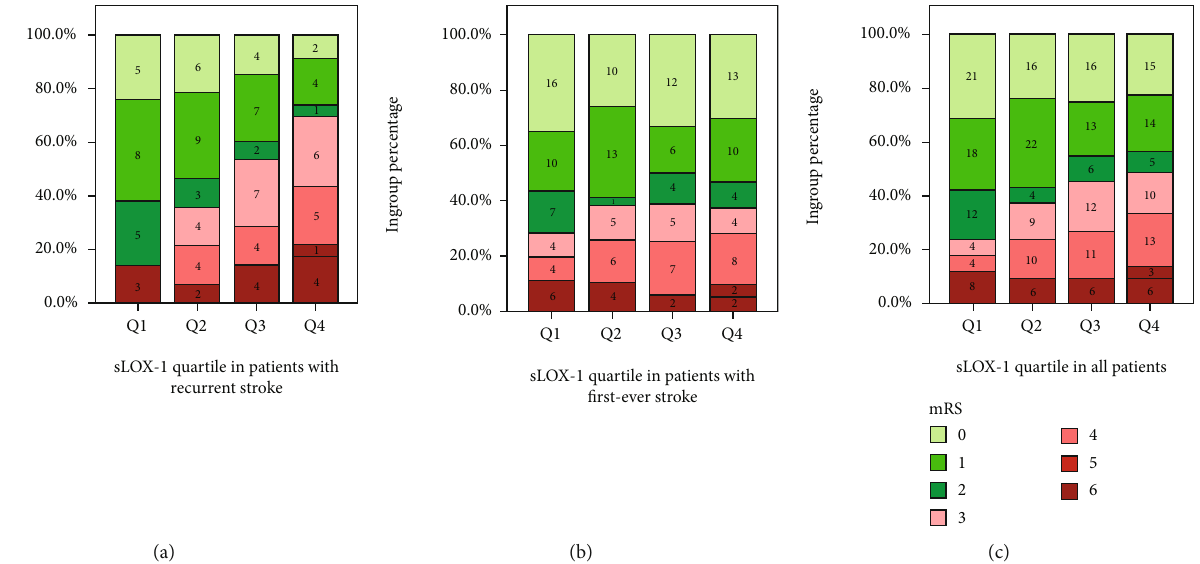
Figure 3: Elevated sLOX-1 levels were correlated with an increased risk of adverse outcomes in patients with recurrent stroke but not in those with fi rst-ever stroke. The proportion of patients with favorable ( mRSscore = 0 – 2) and unfavorable outcomes ( mRS score = 3 – 6) in patients with recurrent ischemic stroke (a), with fi rst-ever stroke (b), and in all patients with AIS (c). Grouped according to the quartile of sLOX-1 level: Q1 represents ≤ 316.72pg/mL, Q2 represents 316.72 – 510.52pg/mL, Q3 represents 510.52 – 877.48pg/mL, and Q4 represents ≥ 877.48pg/mL. Numbers indicate the number of cases per ischemic stroke, as shown in Figure 2 ( r = 0 : 3232 , p = 0 : 001 ).